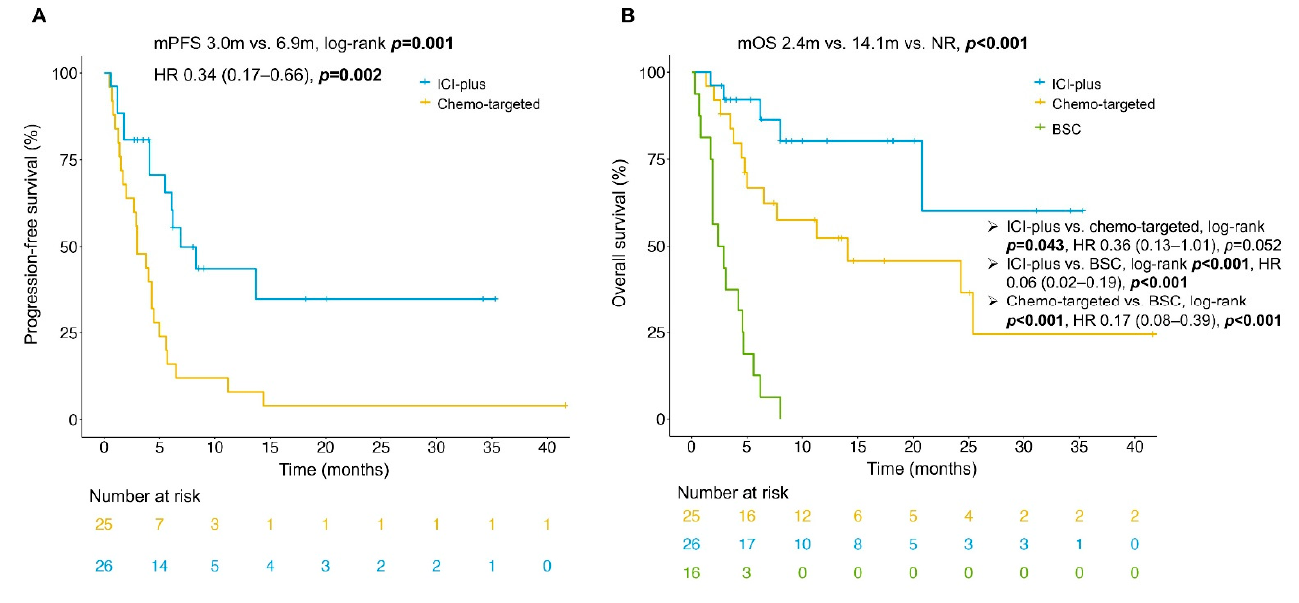
Figure 3. Kaplan–Meier curves of PFS ( A ) and OS ( B ) for MSI/dMMR gastrointestinal cancer patients who received anti-PD1/PD-L1 plus other therapy, chemotherapy with or without targeted therapy and best supporting care (only OS) after progression on prior anti-PD1/PD-L1, respectively. Tick marks mean censored data. The ICI-plus group showed significantly longer PFS ( p = 0.001) and OS ( p = 0.043) than the chemo-targeted group with log-rank analysis. The OS of the BSC group was significantly shorter than the other two groups. Abbreviations: ICI-plus: anti-PD1/PD-L1 plus other therapy; chemo-targeted: chemotherapy with or without targeted therapy; BSC: best supportive care; HR = hazard ratio; mOS: median overall survival; mPFS: median progression-free survival; NR = not reached. Table 2. Overall response between the ICI-plus group and chemo-targeted group.